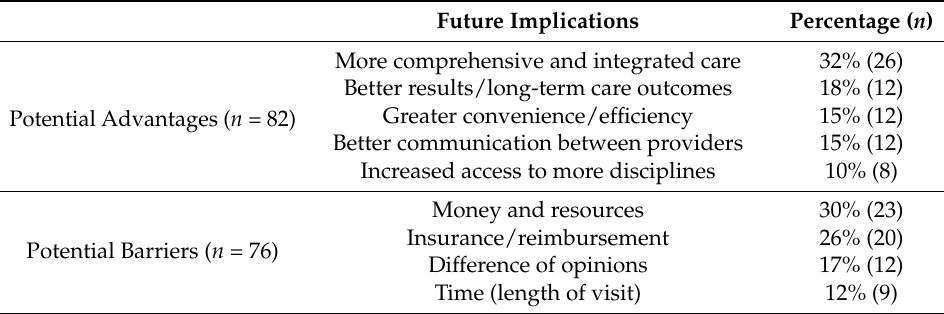
Table 4. The potential advantages and barriers of future multidisciplinary PCOS